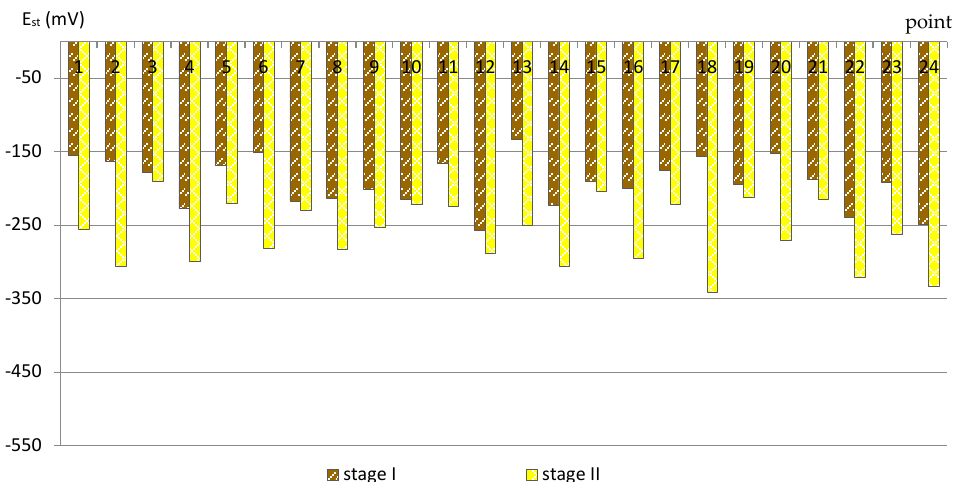
Half-cell potential; Concrete specimens with CEM I and without an air-entraining agent